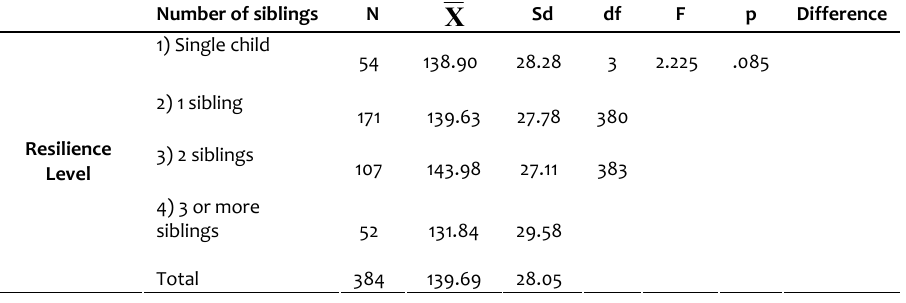
Table 4. Results of ANOVA on Resilience Levels of the 5-Year-Old Preschoolers based on the Number of Siblings